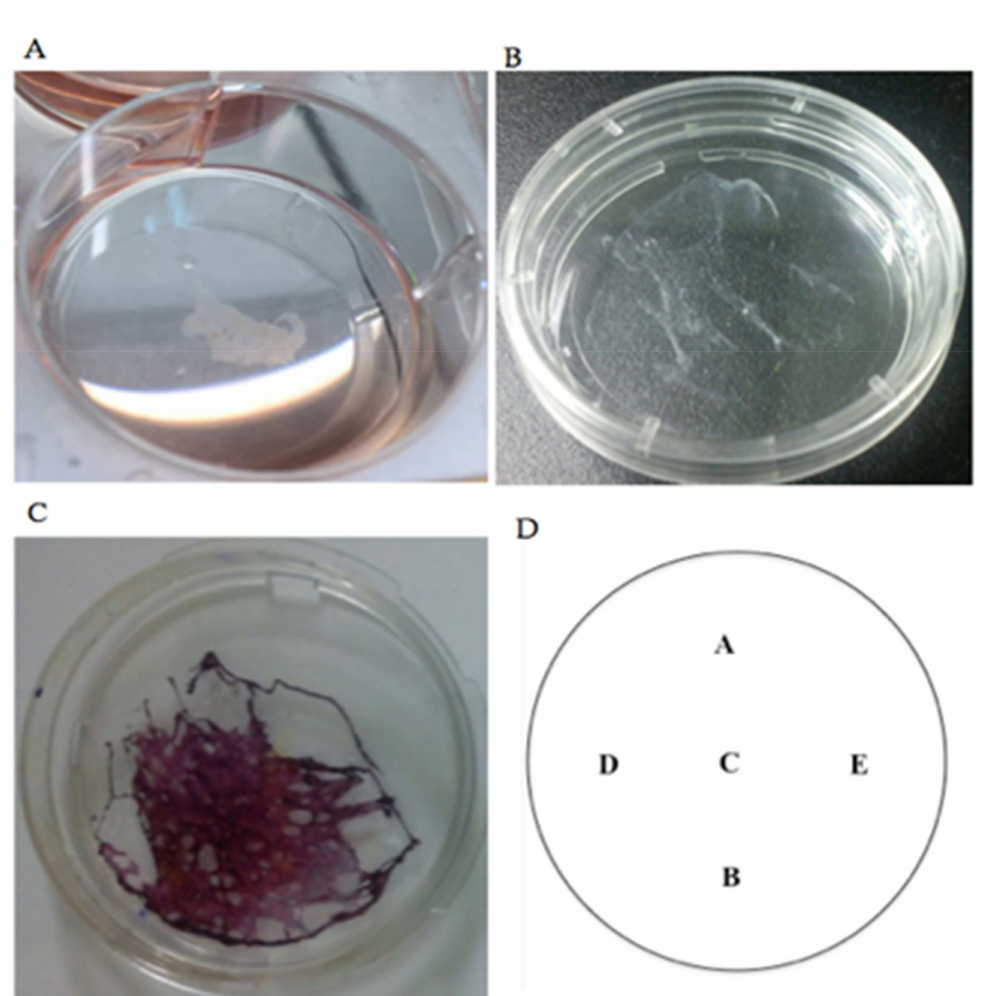
Figure 11. ( A ). Gross view of the floating ASC-based self-assembled scaffold in culture media after being scrapped from the culture plate. ( B ) ASC-based self-assembled scaffold upon transferring into a new culture plate. ( C ). To visualize the scaffold, it was stained with Masson’s trichrome stain. ( D ) Shows the five predetermined positions for measuring the